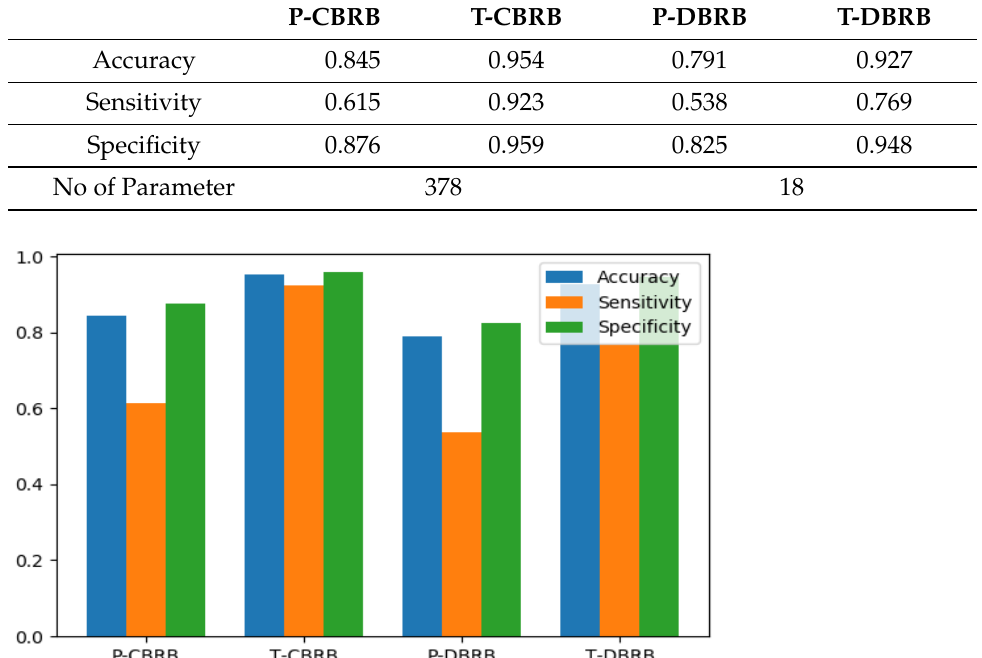
Figure 4. Comparison of Accuracy, Sensitivity and Specificity for P-CBRB, T-CBRB, P-DBRB, and